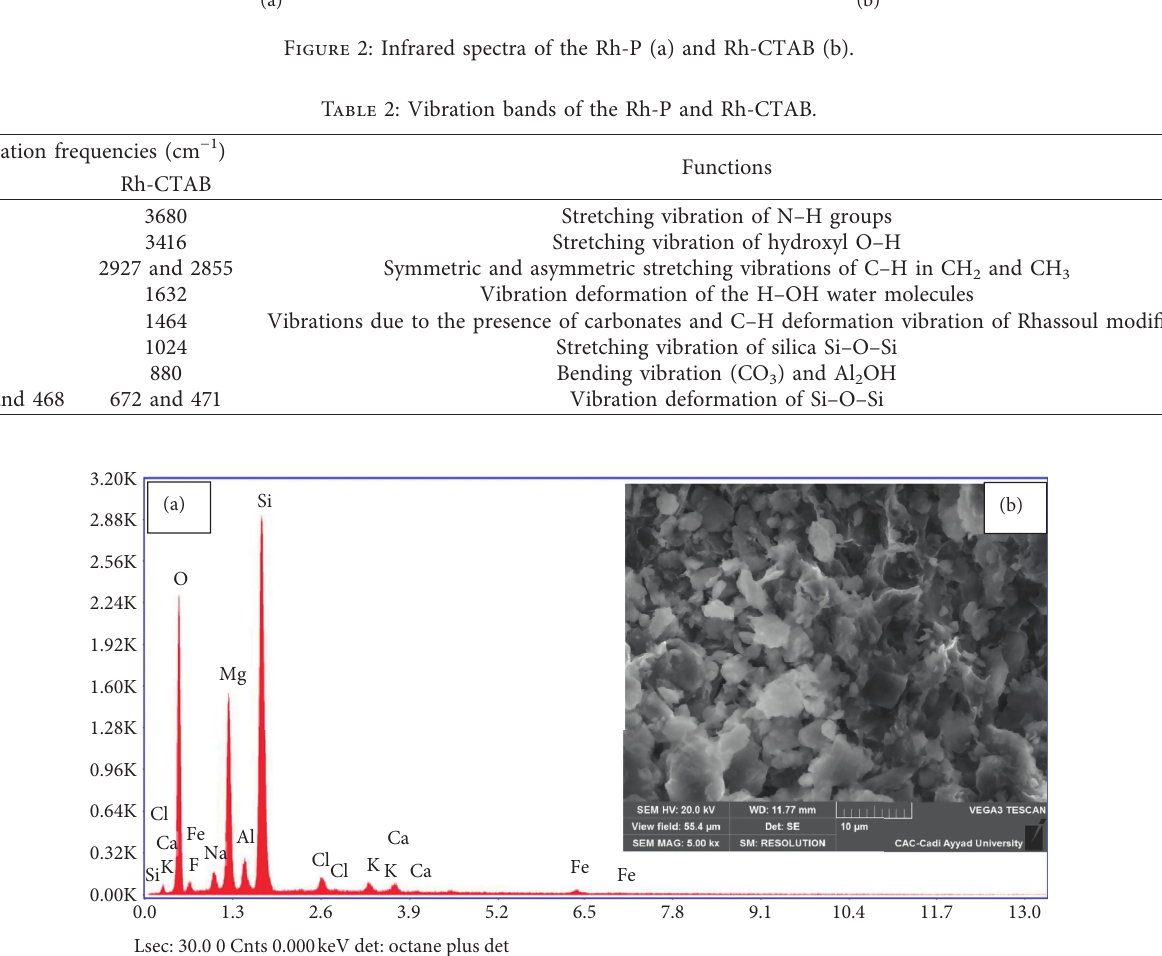
Figure 3: SEM-EDX micrograph of the